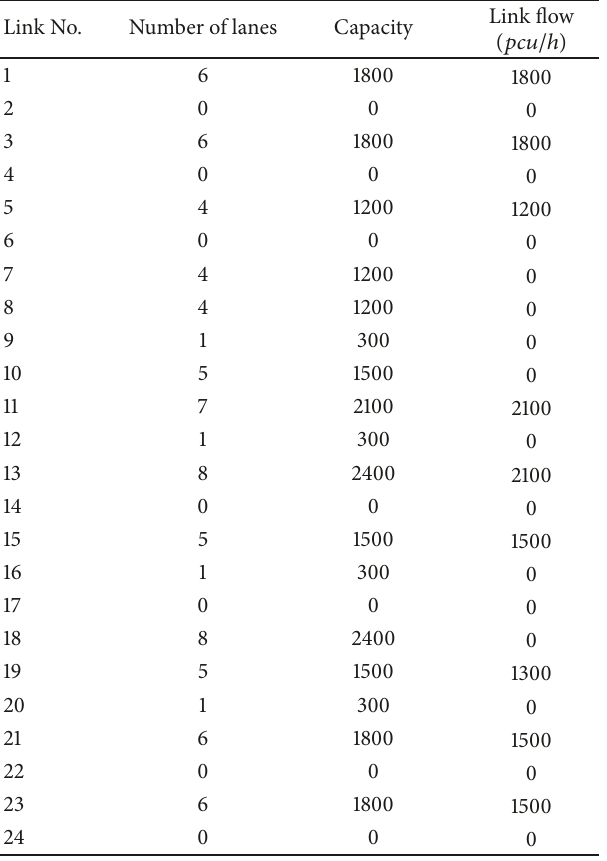
Table 12: Feasible lane distribution scheme and link flow in Case 2 when 𝜇 = 2.00 . Link No.